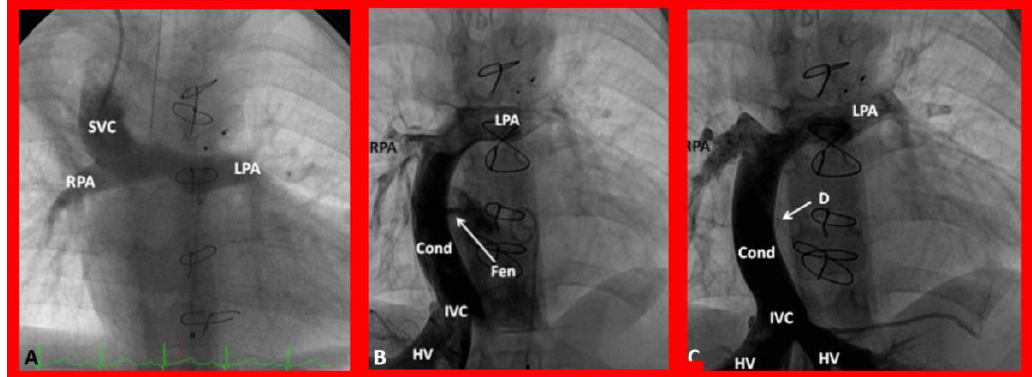
Figure 14. ( A ). Selected cine-angiographic frame showing bidirectional Glenn shunt (Stage II of Fontan). The unobstructed blood flow from the superior vena cava (SVC) into the right (RPA) and left (LPA) pulmonary arteries is seen. ( B ). Selected cine frame in antero-posterior view demonstrating Stage IIIA of the Fontan procedure conveying the inferior vena caval (IVC) blood flow into the RPA and LPA via a non-valve conduit (Cond). The fenestration (Fen) is shown by the arrow in ( B , C ). This cine frame demonstrates occlusion of Fen with an Amplatzer device (D), pointed out by the arrow in ( C ) (Stage IIIB). Sternal wires from prior surgery are seen in ( A – C ) and were not labeled. HV, hepatic veins. Modified from